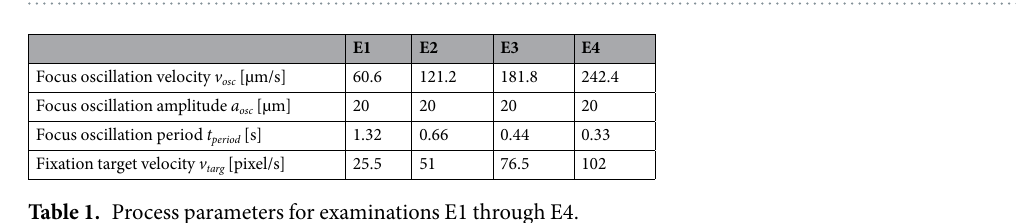
Table 1. Process parameters for examinations E1 through